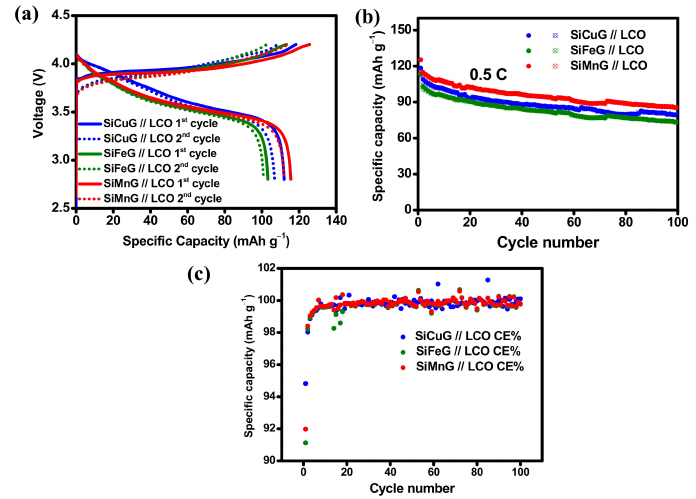
Figure 13. ( a ) Potential vs. specific capacity plots for 1st and 2nd cycles. ( b ) Cyclability, ( c ) Coulombic efficiency results of SiCuG // LCO, SiFeG // LCO, and SiMnG // LCO full cells with 1 M LiPF 6 in EC:DEC:FEC ( v / v ratio of 5:70:25) electrolyte at 0.5 C, in the potential window of 2.8–4.2 V, respectively.